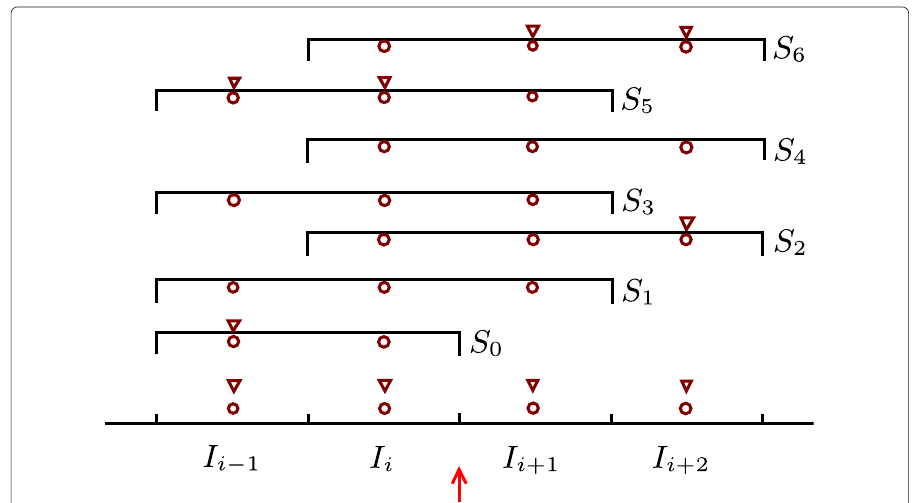
Fig. 4 Sub-stencils in the reconstruction for left side value of the cell interface x i + 1 / 2 in the compact 6th-order and 8th-order reconstruction: the circles represent cell averages, and the gradients represent cell averaged